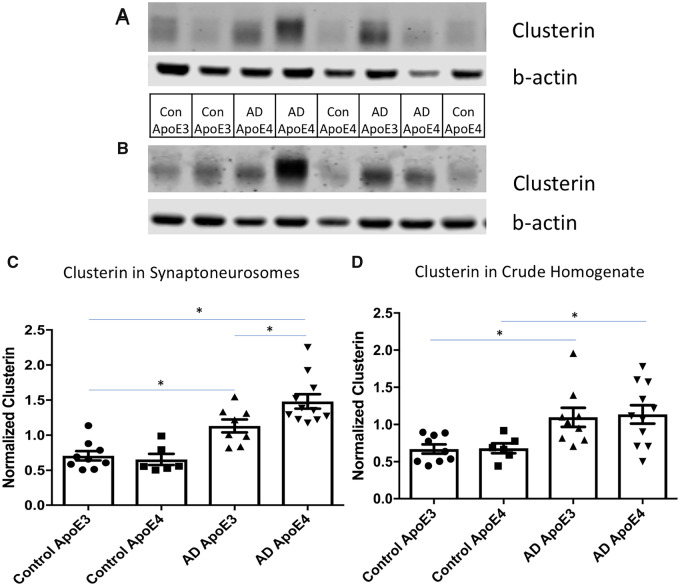

Clusterin is increased in the synaptic compartment in Alzheimer's disease with highest levels in APOE4 carriers. Western blot (A, B) analysis shows an increased level of clusterin when comparing Control with Alzheimer's disease in both Crude Homogeante (A, C) and in Synaptically enriched preps (B, D). In synapses, there is a further increase in the Alzheimer's disease APOE4 cases compared with Alzheimer's disease APOE3 cases (*Tukey’s post hoc tests, P < 0.05).